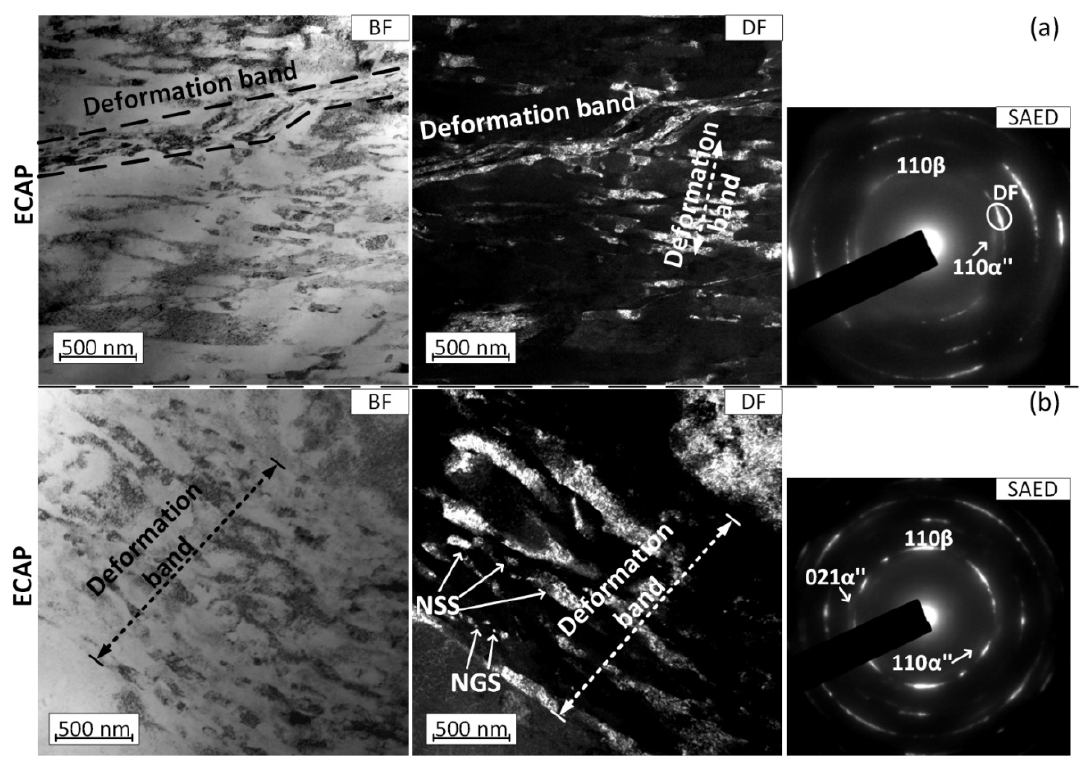
Figure 5. TEM images of selected typical zones ( a , b ) of Ti-18Zr-15Nb alloy after ECAP. Bright field (BF) and dark field (DF) images, and SAED patterns.